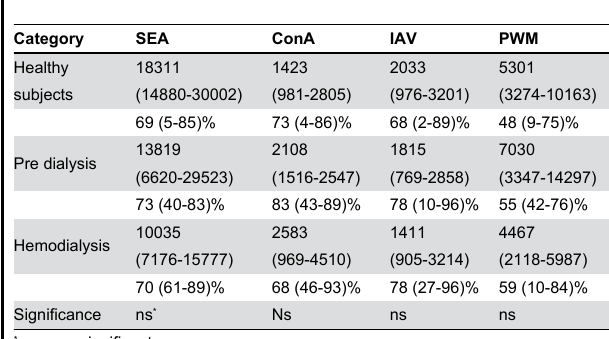
Table 2. Laboratory data for blood parameters.